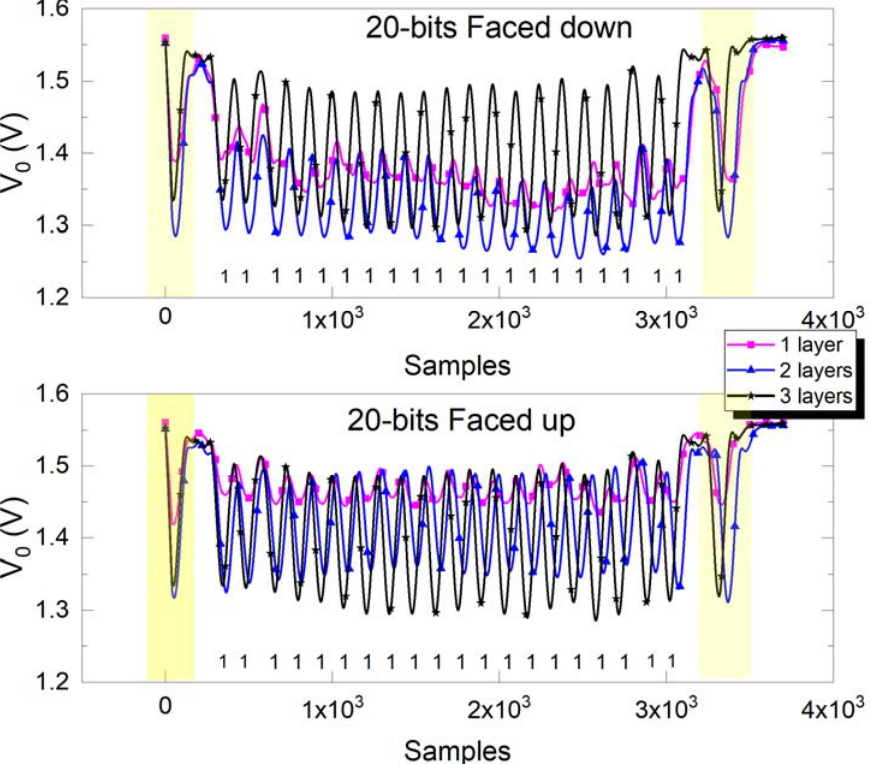
Figure 5. Measured envelope functions of the fabricated tags as a function of one two and three ink layers printed.